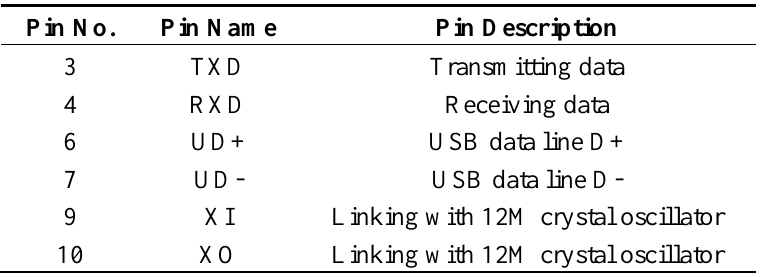
Table 5. The pins description of CH340T